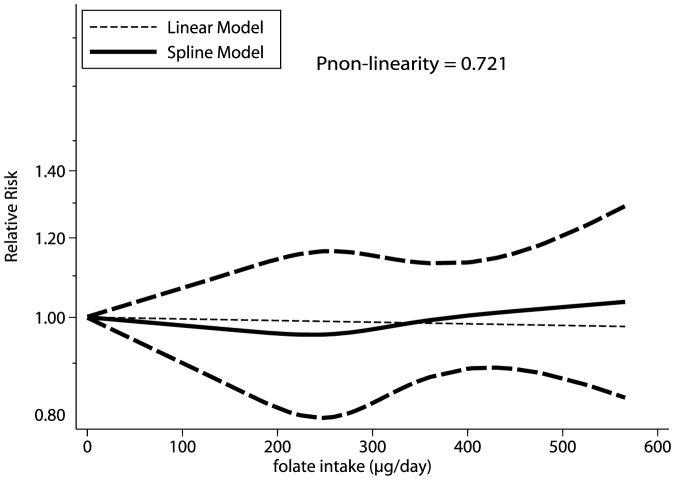
Dose-response relations between folate intake and relative risks of lung cancer.